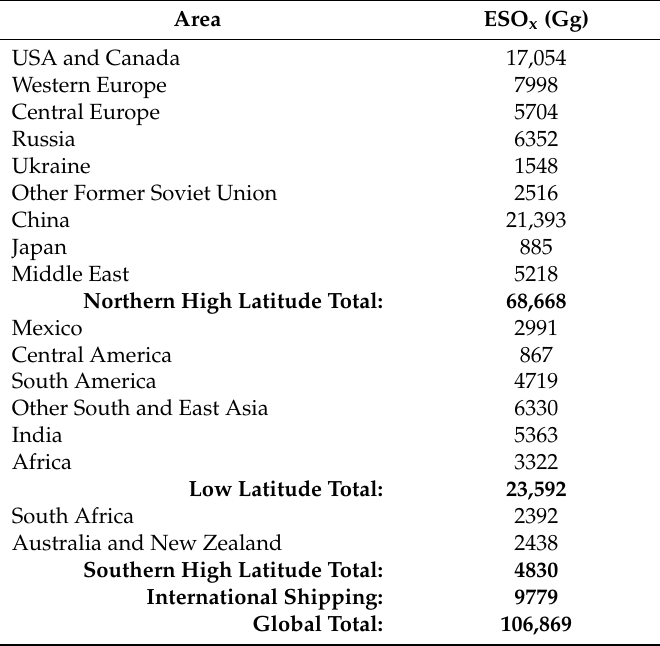
Table A1. Anthropogenic sulfur emissions and radiative forcing vales for the year 2000, reordered into regional sections